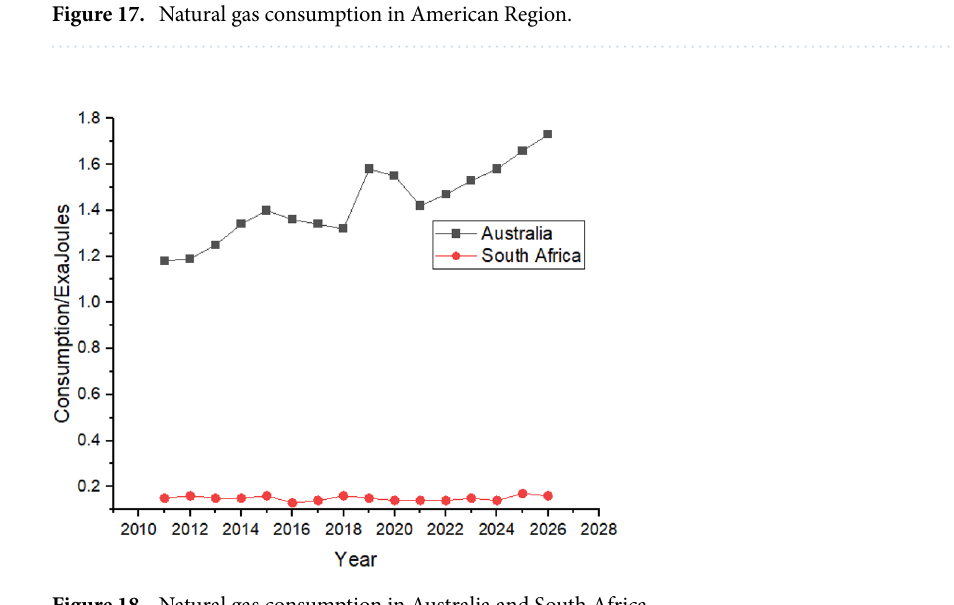
Figure 18. Natural gas consumption in Australia and South